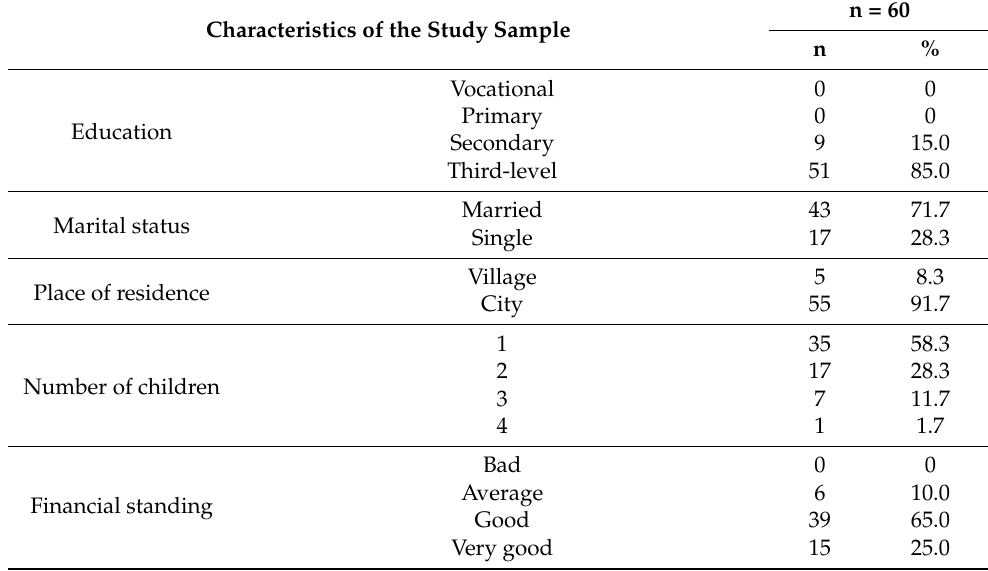
Table 1. Characteristics of the study